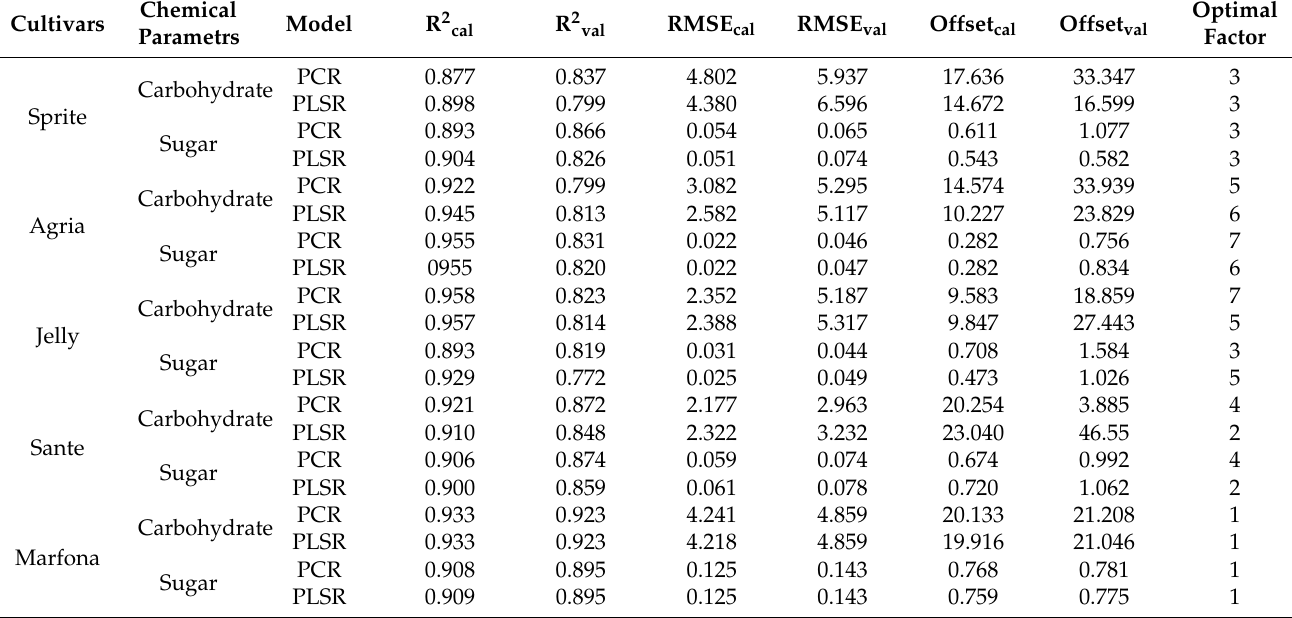
Table 3. PLSR and PCR model analysis results for predicting sugars, carbohydrates, and toughness